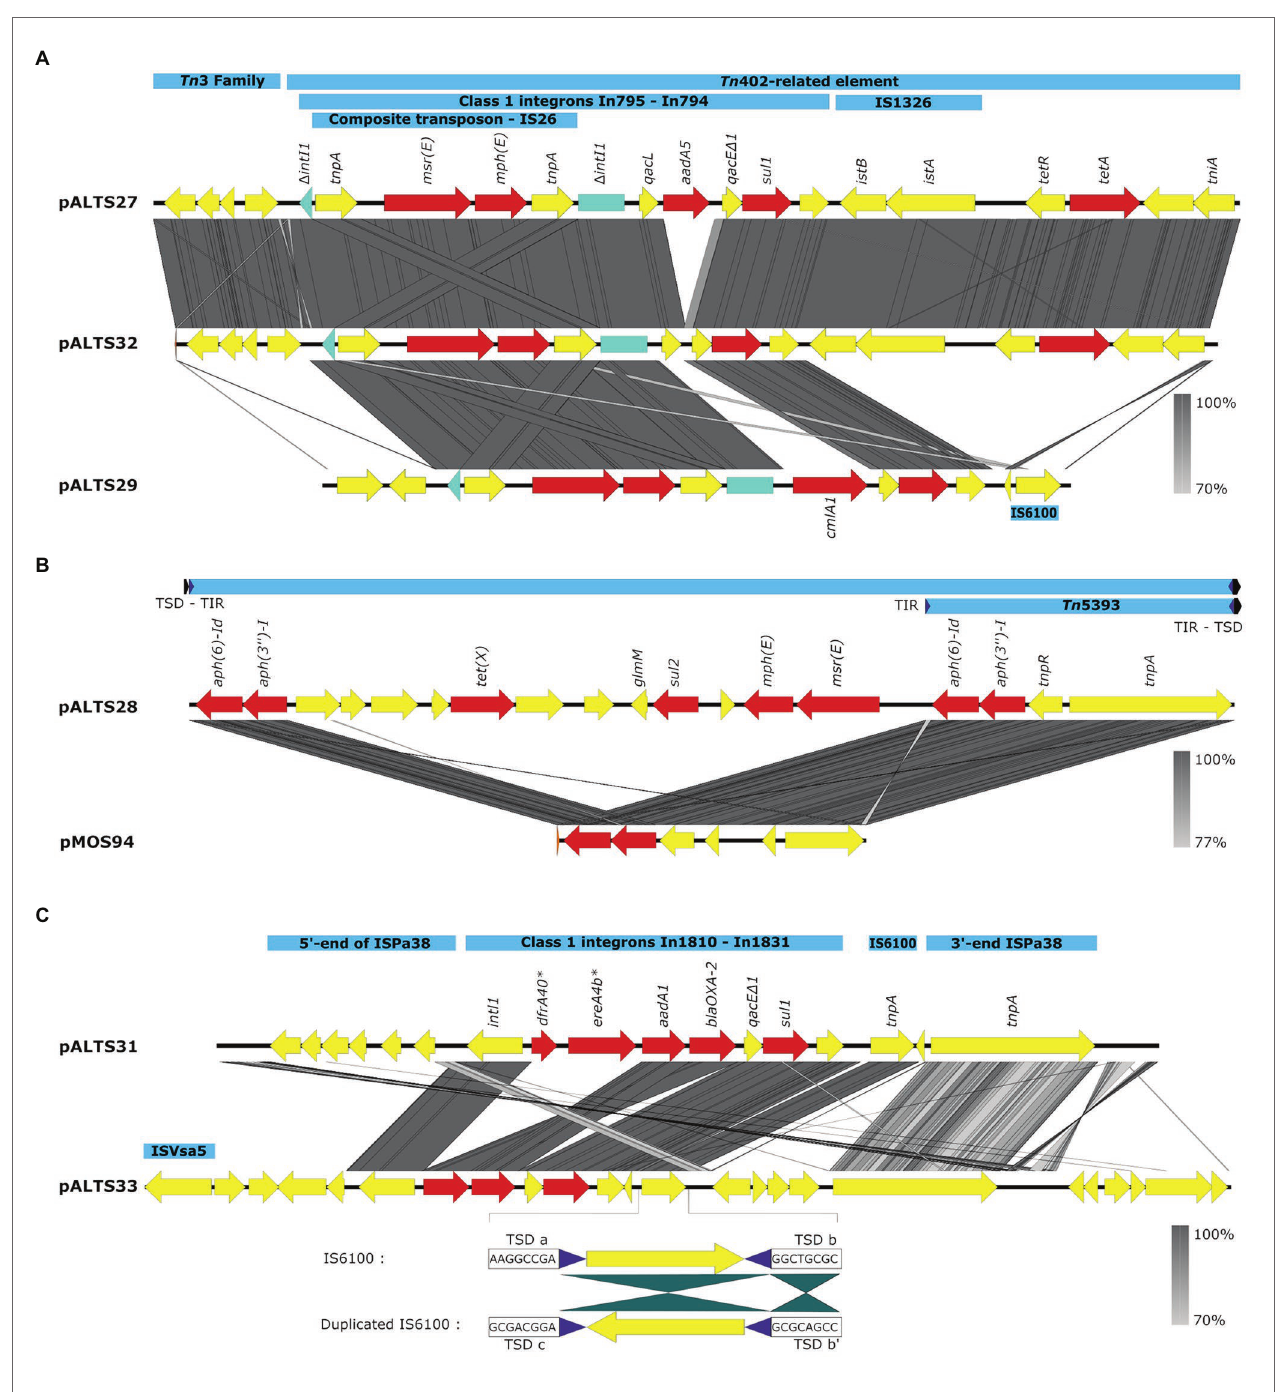
FIGURE 4 | Comparative analysis of the accessory regions of the pALTS plasmids showing key mobile genetic elements in blue, ARGs in red, and other CDSs in yellow. (A) Comparisons of accessory regions of pALTS27, pALST32, and pALTS29. The interrupted class 1 integron integrase gene is shown in green. (B) Comparison of pALTS28 accessory region with its best BLASTn hit (www.ncbi.com), a mobile genetic element of the plasmid pMOS94 (accession: MK671725.1). (C) Comparison of accessory regions of pALTS31 and pALTS33, including details of the duplicated IS6100 in pATS33 showing the inverted conformation of the duplication and the target site duplication (TSD); b’ is the inverted TSD of b. Terminal inverted repeat (TIR) are shown by purple arrows and TSD by a black arrow. Comparative analysis was visualized using Easyfig 2.2.2 (Sullivan et al., 2011) using a predicted protein similarity threshold above 70%. *In1810 carried two putative ARG cassettes dfr40 and ereA4b not identified by AMRfinder. Those two predicted proteins were 100% identical to a trimethoprim-resistant dihydrofolate reductase DfrA and an EreA family erythromycin (E) esterase in the non-redundant protein database from